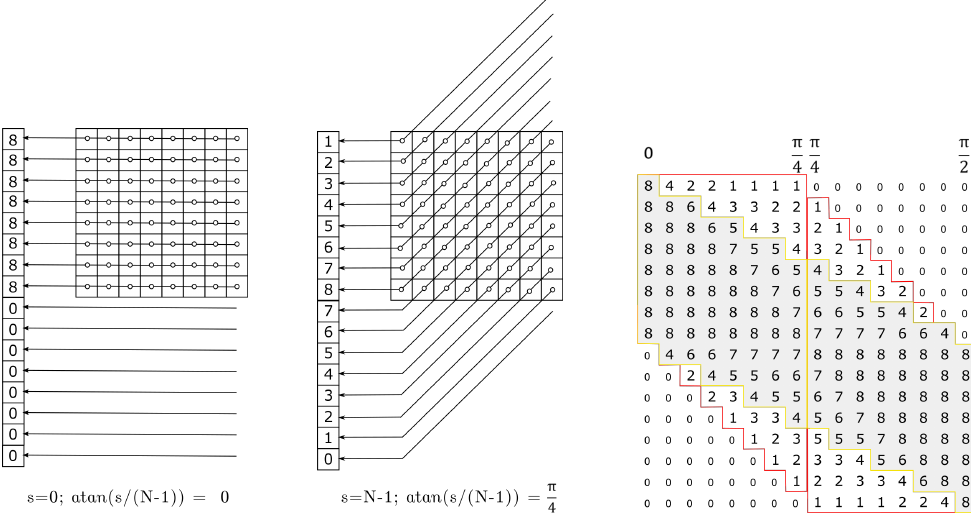
Figure 2. Number of pixels to be summed together at different displacements, when calculating DRT for s = 0 (left) and s = N − 1 (middle). The number of pixels evaluated for the rest of slopes and displacements of two quadrants of a 8 × 8 image are shown on the